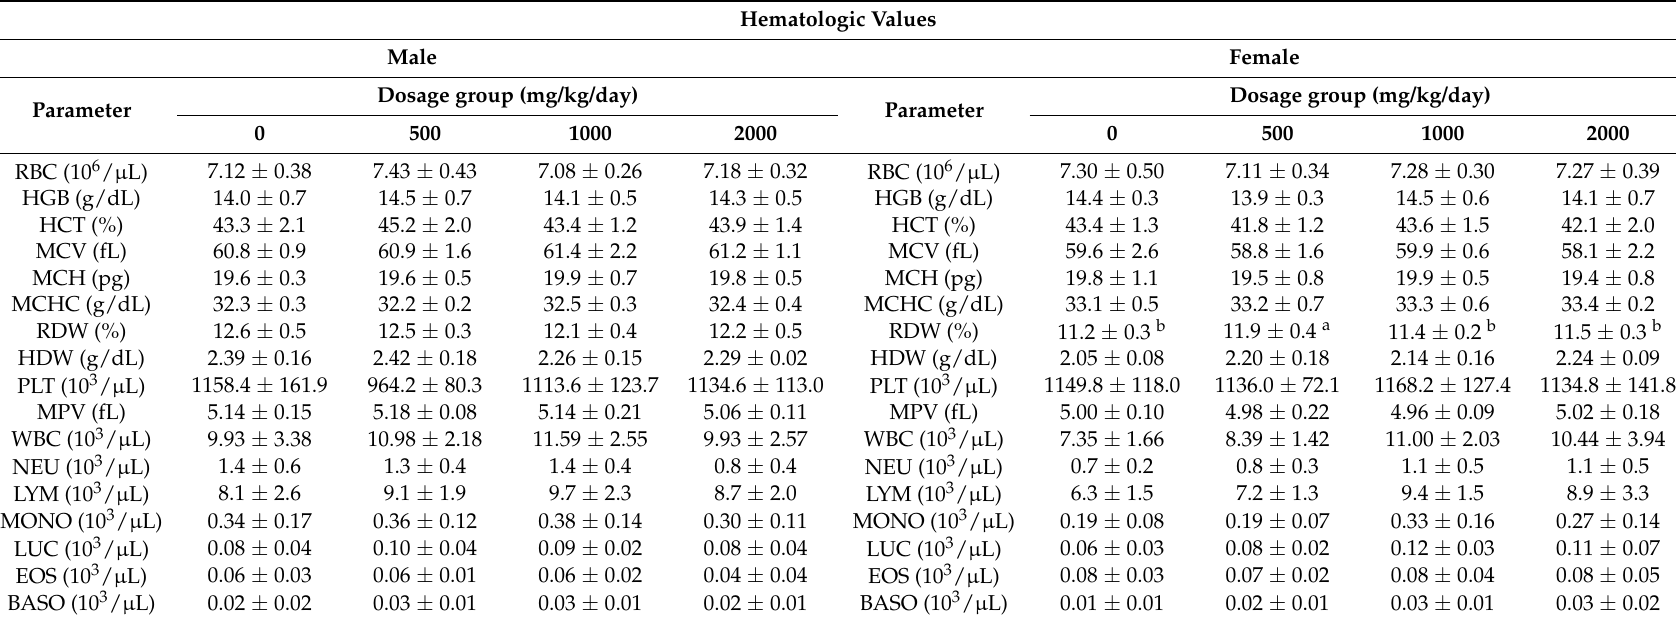
Table 2. Hematologic values for male and female rats exposed to 500, 1000, or 2000 mg/kg/day GEE for 14 days in a repeated oral dose toxicity study. Hematologic